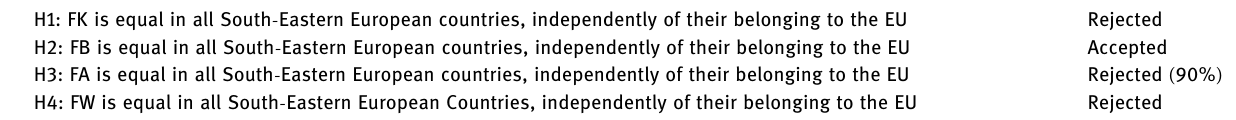
Table 5: Results of H1 to H4 testing H1: FK is equal in all South - Eastern European countries, independently of their belonging to the EU